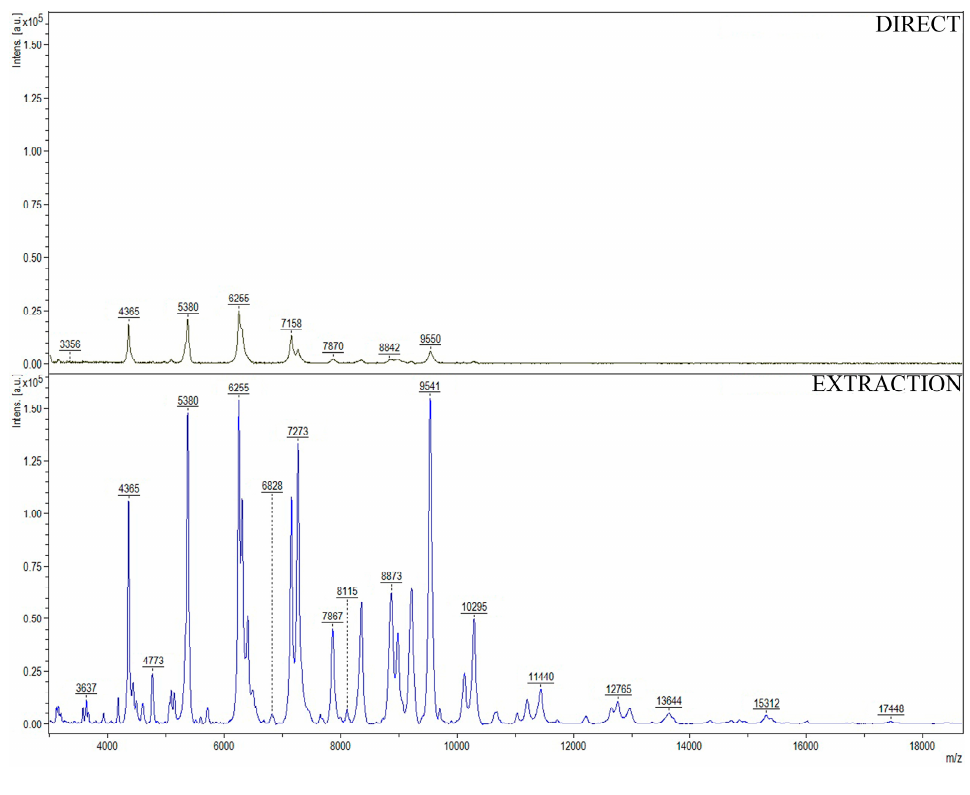
Figure 2. Representative (from triplicate experiment) matrix-assisted laser desorption/ionization–time-of-flight mass spectrometry (MALDI-TOF MS) spectra of E. coli in MH medium obtained using the “DIRECT” and “EXTRACTION” procedure.